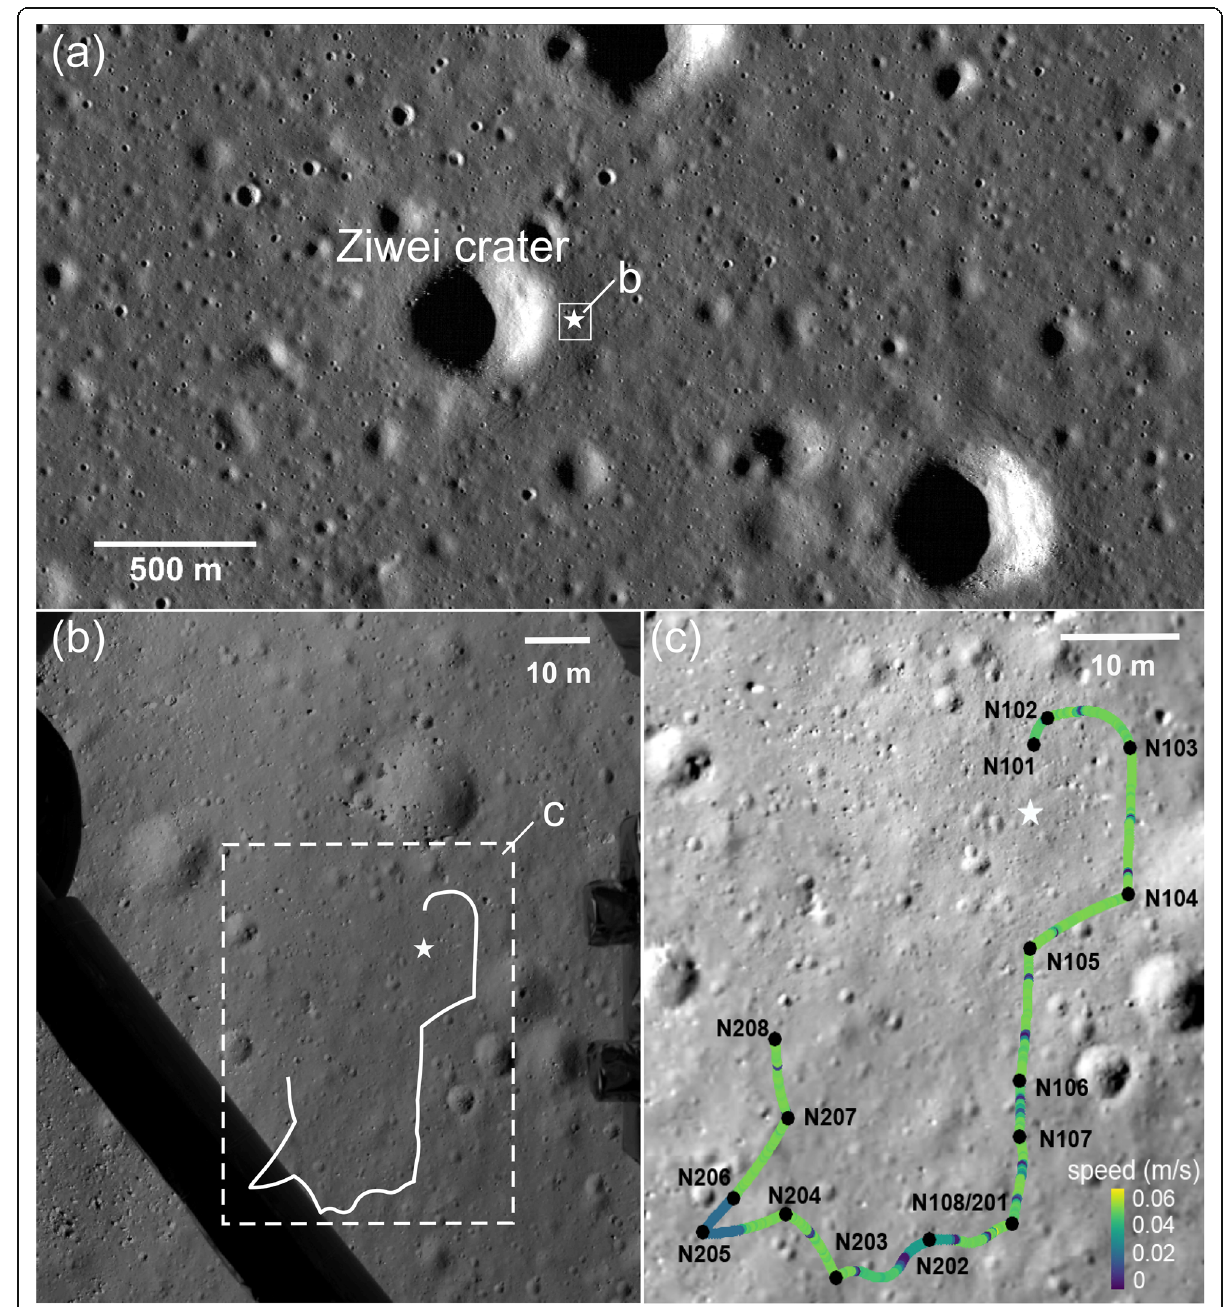
Fig. 1 The landing site of the Chang ’ e-3 mission and the traverse route of the Yutu rover. a Geological context of the landing site. The landing site (white star) is located on the rim of the ~ 450 m diameter Ziwei crater. The base image is obtained by the Lunar Reconnaissance Orbit (M102285549LE+RE; 1.66 m/pixel). b Image acquired by the descent camera (image ID: CE3_BMYK_LCAM-3006) on the Chang ’ e-3 lander shows numerous small craters within the landing site. The landing site is marked by the white star and the white line is the route of the Yutu rover. c Traverse route and speed of the Yutu rover from the navigation points N101 to N208 (black dots). The color bar is for the moving speed of the rover. Navigation points that are started with ‘ 1 ’ represent the first lunar day, and ‘ 2 ’ represents the second lunar day. The white star represents the position of